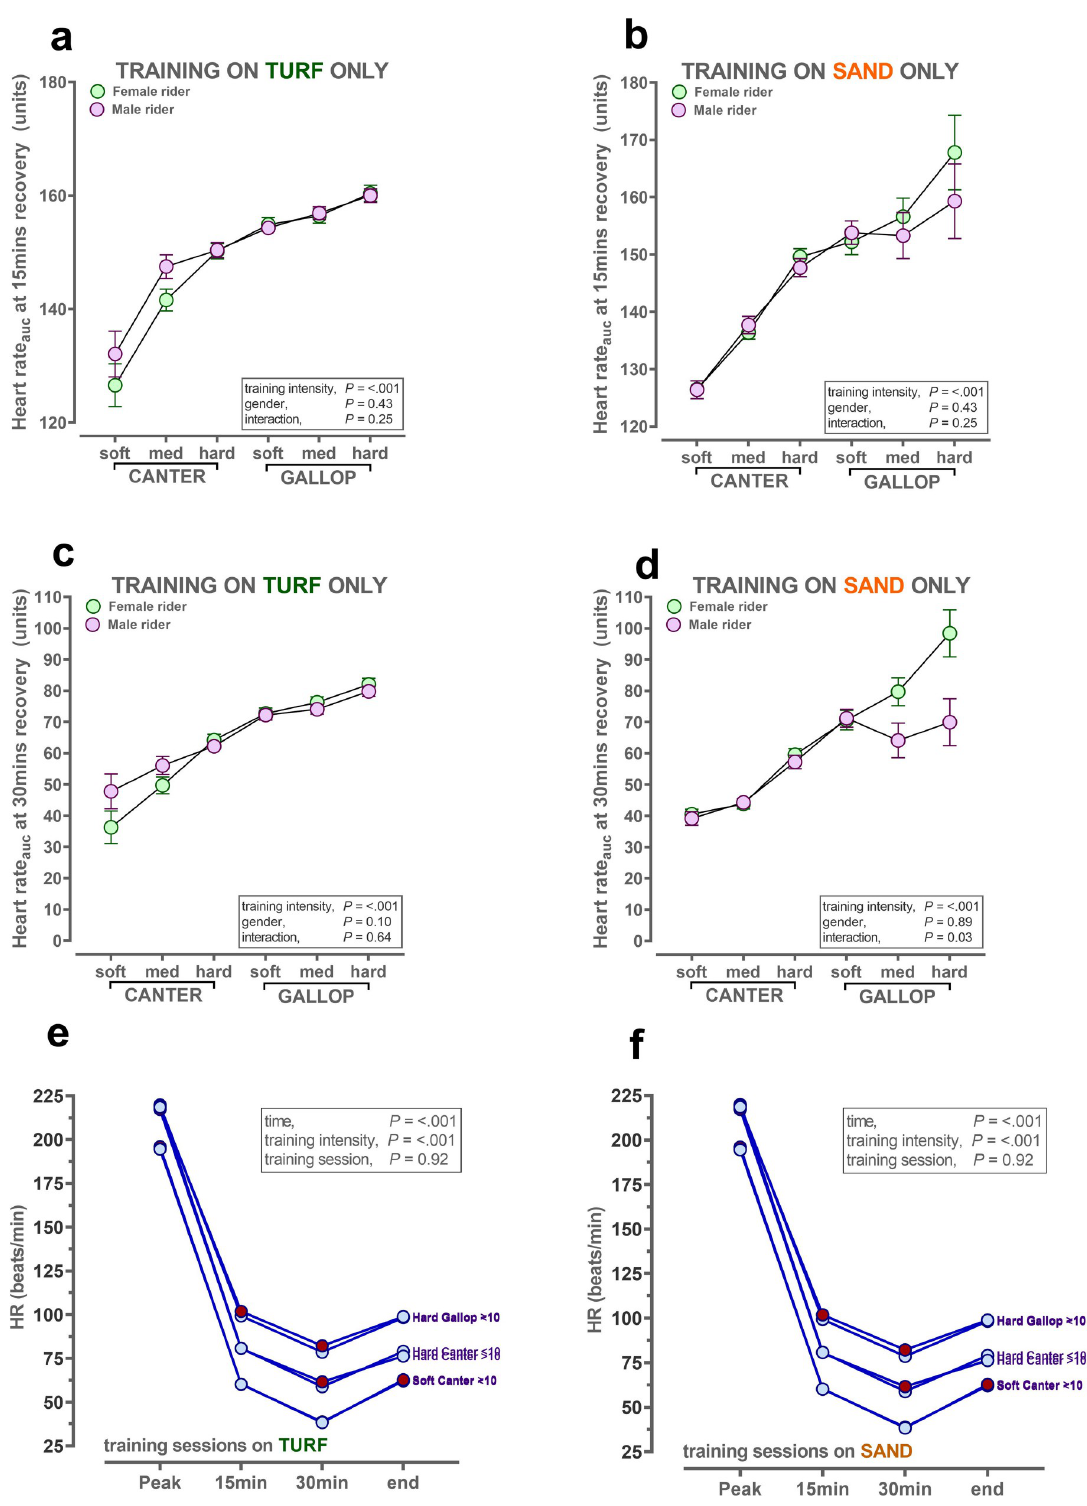
Fig 4. Recovery of racehorse heart rate on different track surfaces by sex of work rider. a,b,c,d: Values are predicted mean ± S.E.M. for continuous data recorded by ‘Equimetre’ in a cohort of racehorses in Australia (n = 130 different racehorses, n = 1,754 different training sessions). Data were available throughout the year. Training intensity (soft/med/hard canter; soft/med/hard gallop) was derived